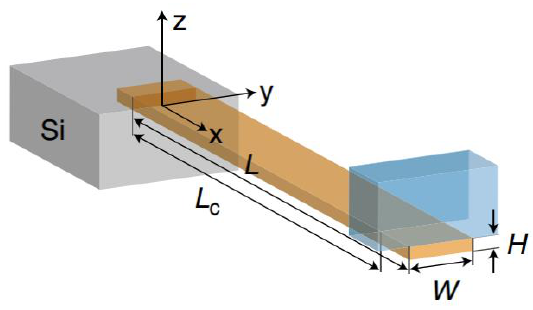
Figure 7. The geometry of the system [30].